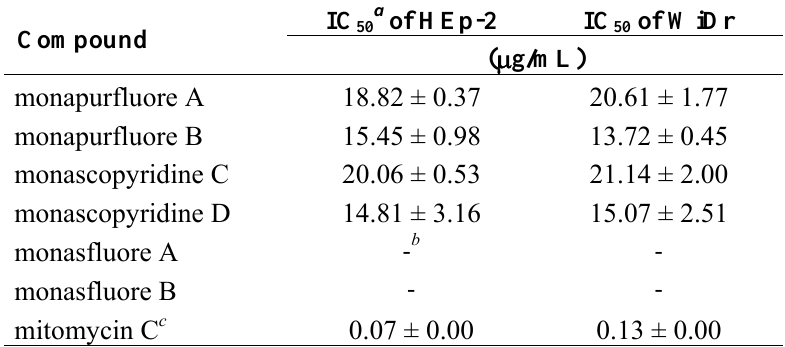
Table 2. Anti-proliferation Effects of Compounds 1 - 6 for HEp-2 and WiDr Cell